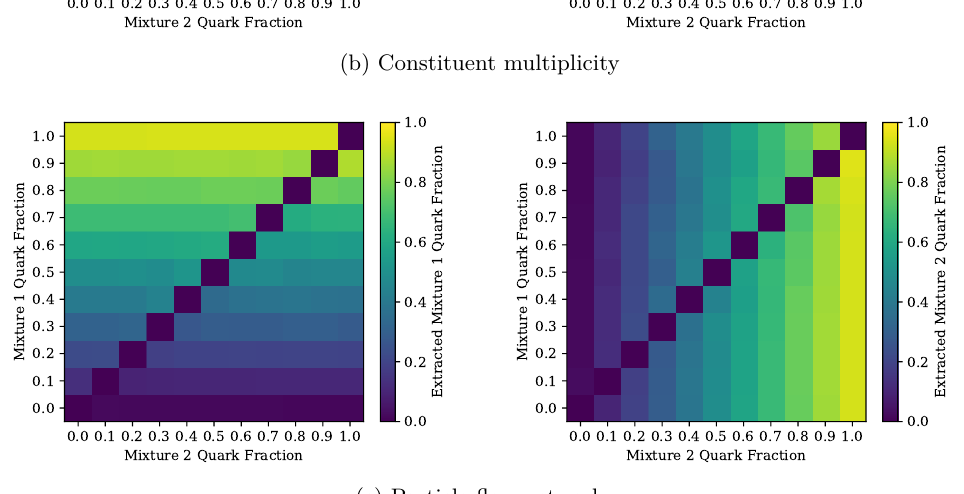
(c) Particle flow network Figure 3 . The (top row) true and (bottom row) extracted quark fractions of (left column) mixture 1 and (right column) mixture 2 for different quark fraction values between zero and one. The (middle row) jet constituent multiplicity or (bottom row) the output of a particle-flow network trained to discriminate quark and gluon jets was used to construct the topics used for the extraction of the quark